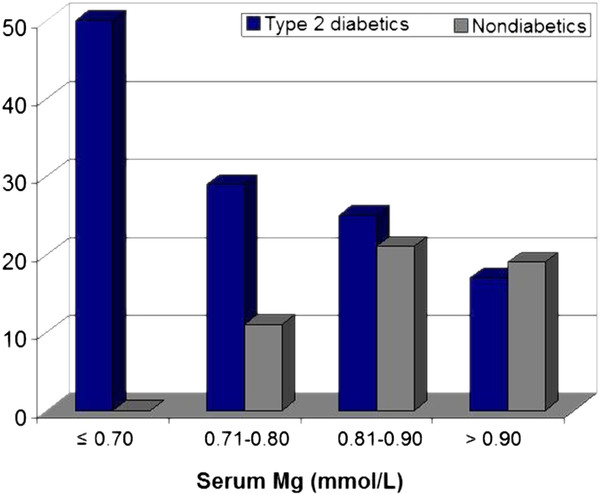
PVC prevalence (%) during 2-hr Holters among adults without CVD (n = 652) by sMg concentrations (mmol/L) and diabetic status1. Legend: PVC prevalence declined with sMg concentration in adults with T2DM (blue bars) only (p < 0.001 for trend), even when hypomagnesemic adults were excluded (p = 0.005 for trend). While no nondiabetic (grey bars) had PVC during monitoring, only 1% of nondiabetics were hypomagnesemic (sMg ≤ 0.70 mmol/L)